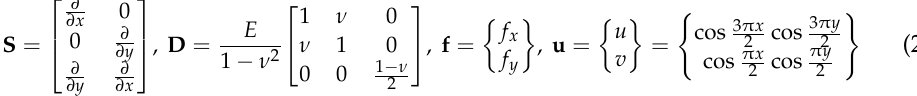
Figure 7. Error distributions.